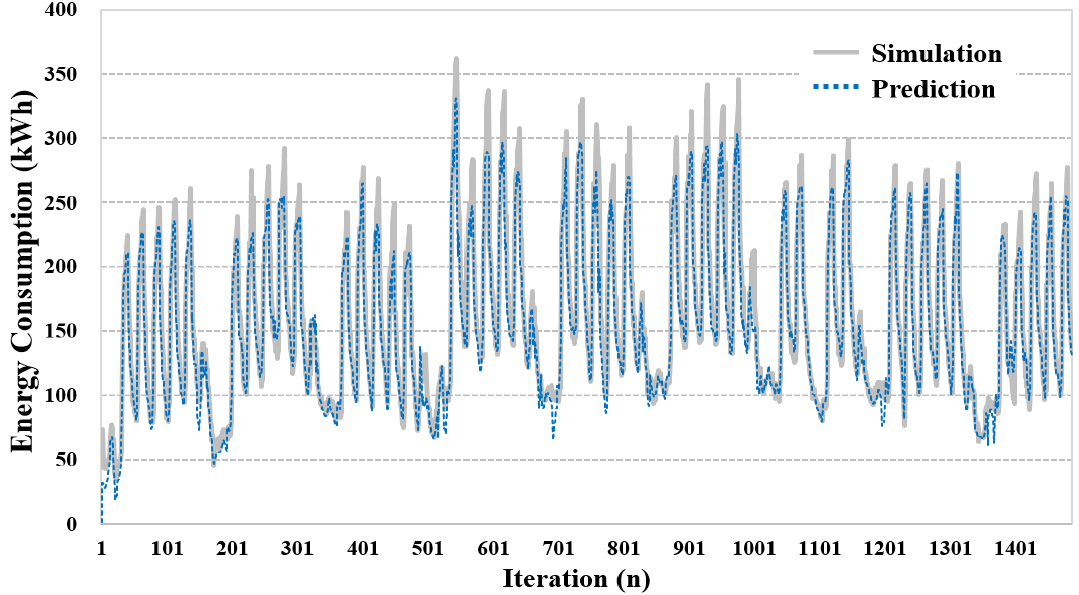
Figure 10. Comparison of the cooling energy consumption between the simulation and prediction.